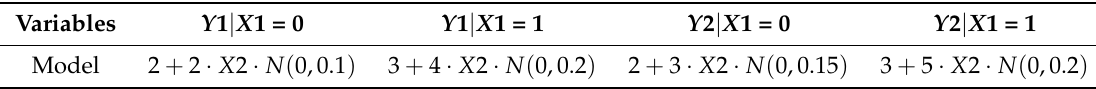
Table 3. Output variables for linear